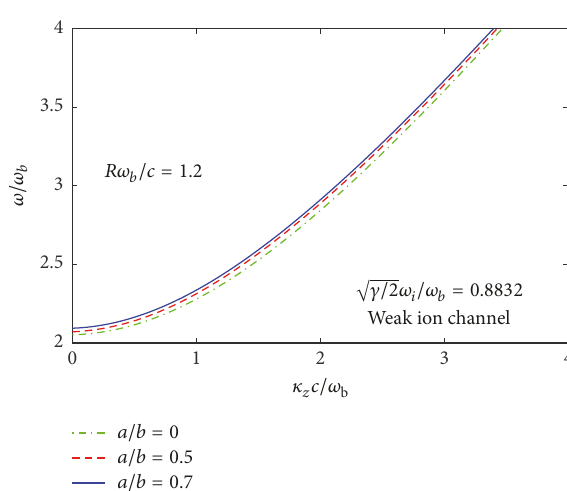
Figure 11: The effect of the ratio 𝑎/𝑏 on the dispersion curves of the TM 01 modes for weak ion channel with 𝜔 𝛽 = 0.8832 . The outer radius of the annular beam is taken as 𝑏 = 0.4𝑅 and 𝑎/𝑏 = 0 represents the solid beam case.